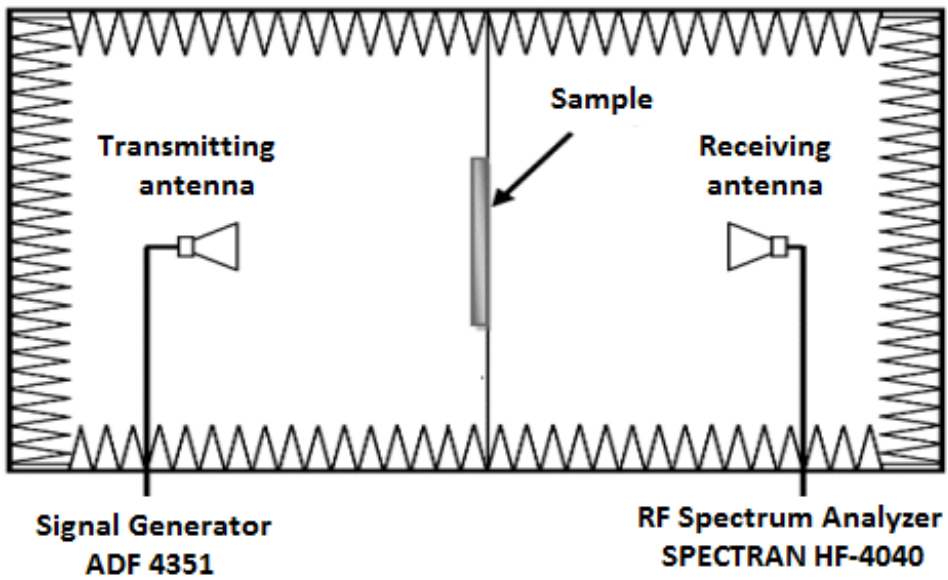
Figure 2. Transmission technique for measuring electromagnetic shielding in anechoic